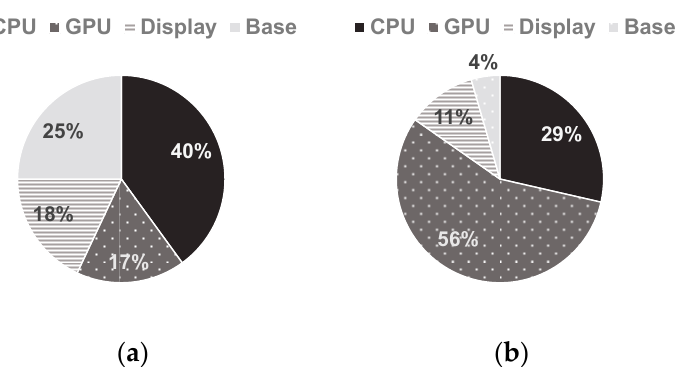
Figure 1. Smartphone power breakdowns while running game applications on ( a ) Galaxy S3, ( b ) Galaxy S7.